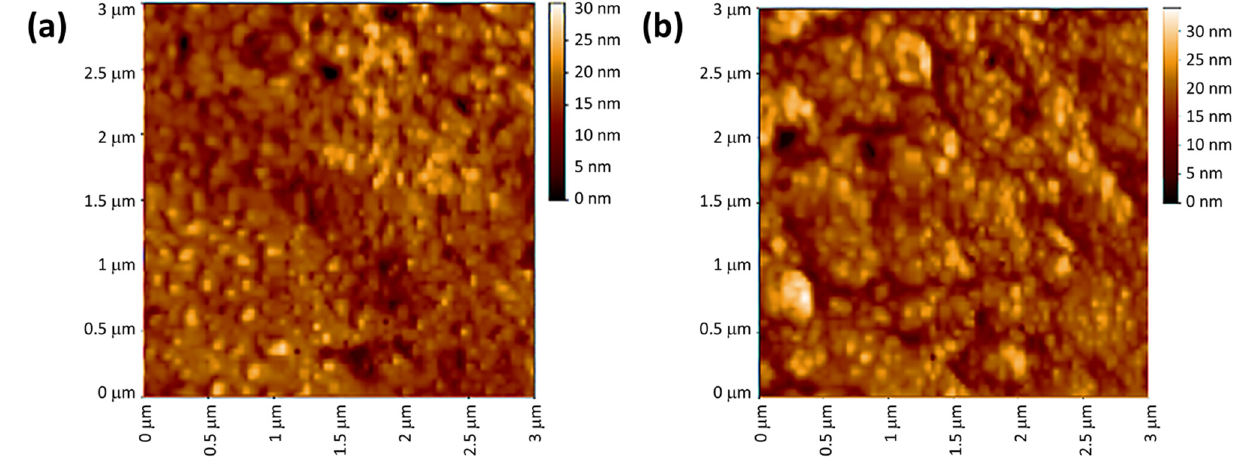
Figure 10. AFM Images of ( a ): pure PVC and ( b ): PVC containing clotrimazole after irradiation.